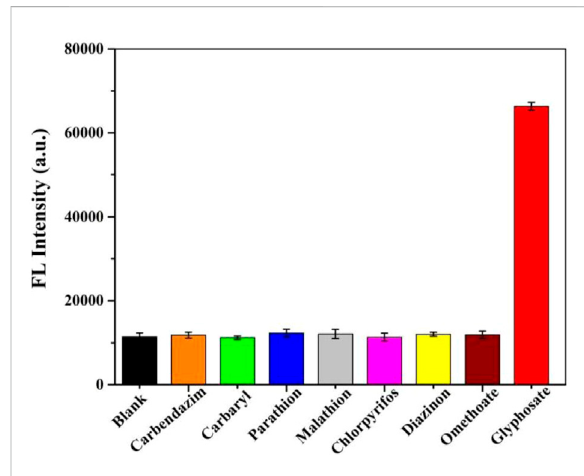
FIGURE 7 Selectivity of the present method for glyphosate. The concentrationwas5 μ g/mlforglyphosate,andtheconcentrations were 100 μ g/ml for other